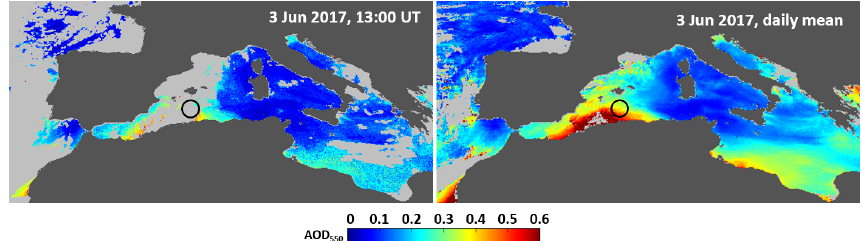
Figure 6. Aerosol optical depth at 550nm derived from MSG/SEVIRI on 3 June 2017. Left: from the 15mn image acquired at 13:00UT. Right: daily average from all 15min products available between 04:00 and 18:30UT. The black circle indicates the position of the ship (station FAST). The dark grey mask corresponds to land and coastal ocean pixels the light grey to cloudy